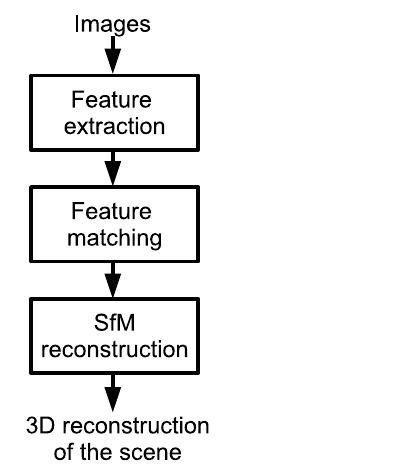
Figure 3: Reconstruction procedure